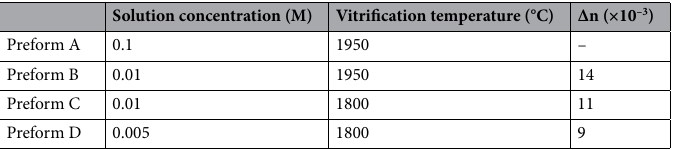
Table 1. Preform fabrication conditions and refractive index contrast for Ca-based nanoparticles doped